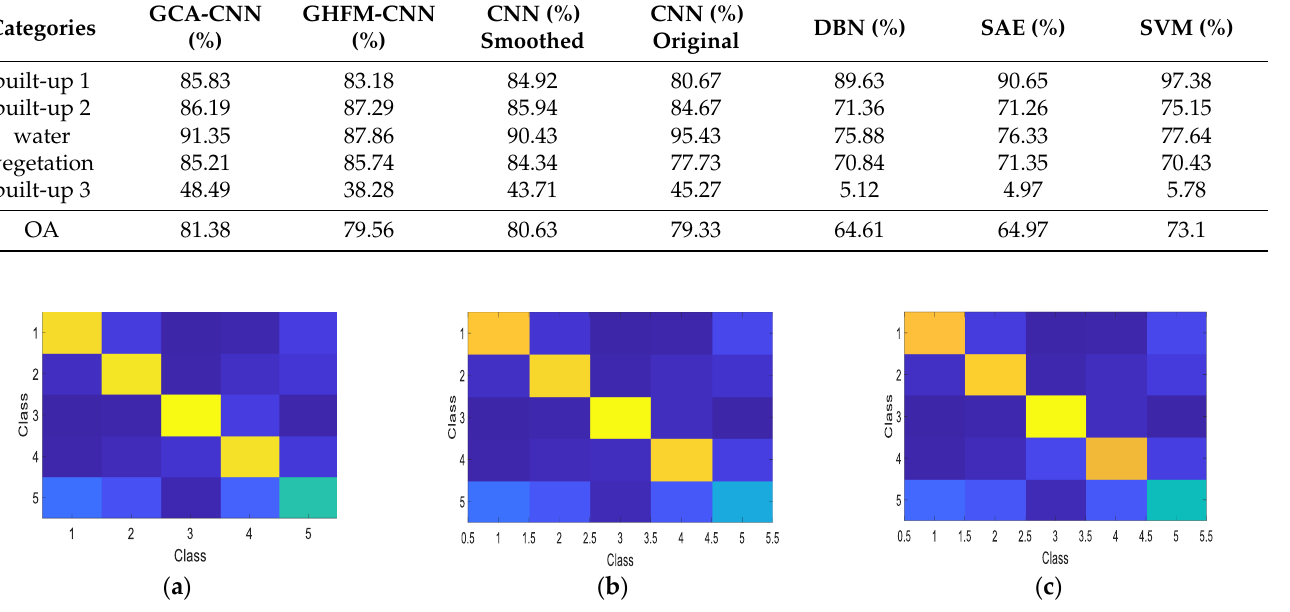
Figure 11. The confusion matrices of the ( a ) GCA-CNN, ( b ) GHFM-CNN and ( c ) OI-CNN on the SanFransisco-Bay image. Table 2. Accuracies of algorithms on SanFrancisco-Bay SAR image.